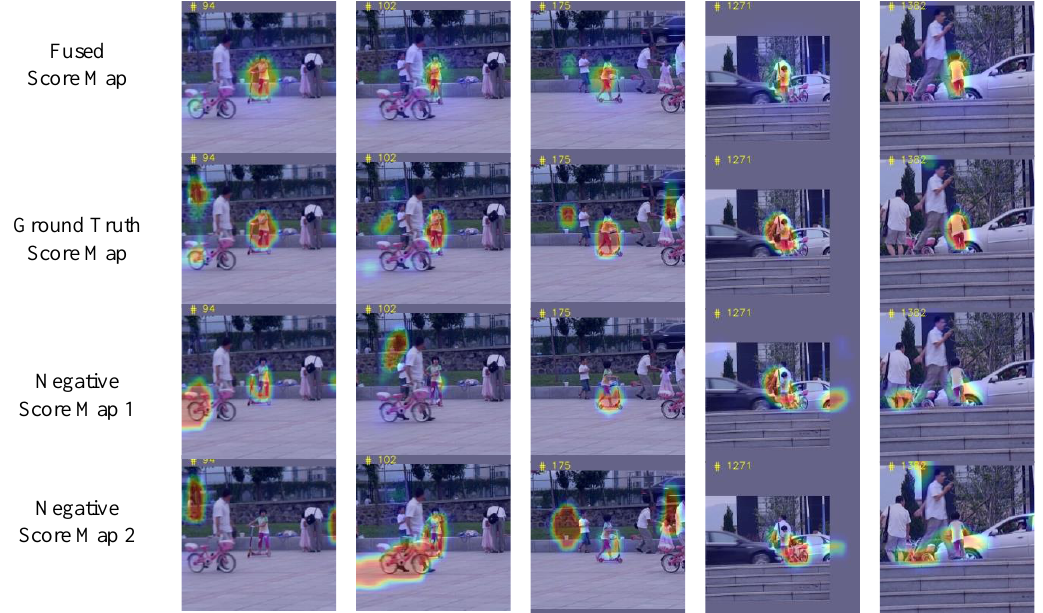
Figure 1. Illustration of our score fusion procedure. The ground truth score map not only responds to the real target but also raises the responses in many other areas where the tracker is easily misled. After implementing fusion, the unrelated responses are sufficiently